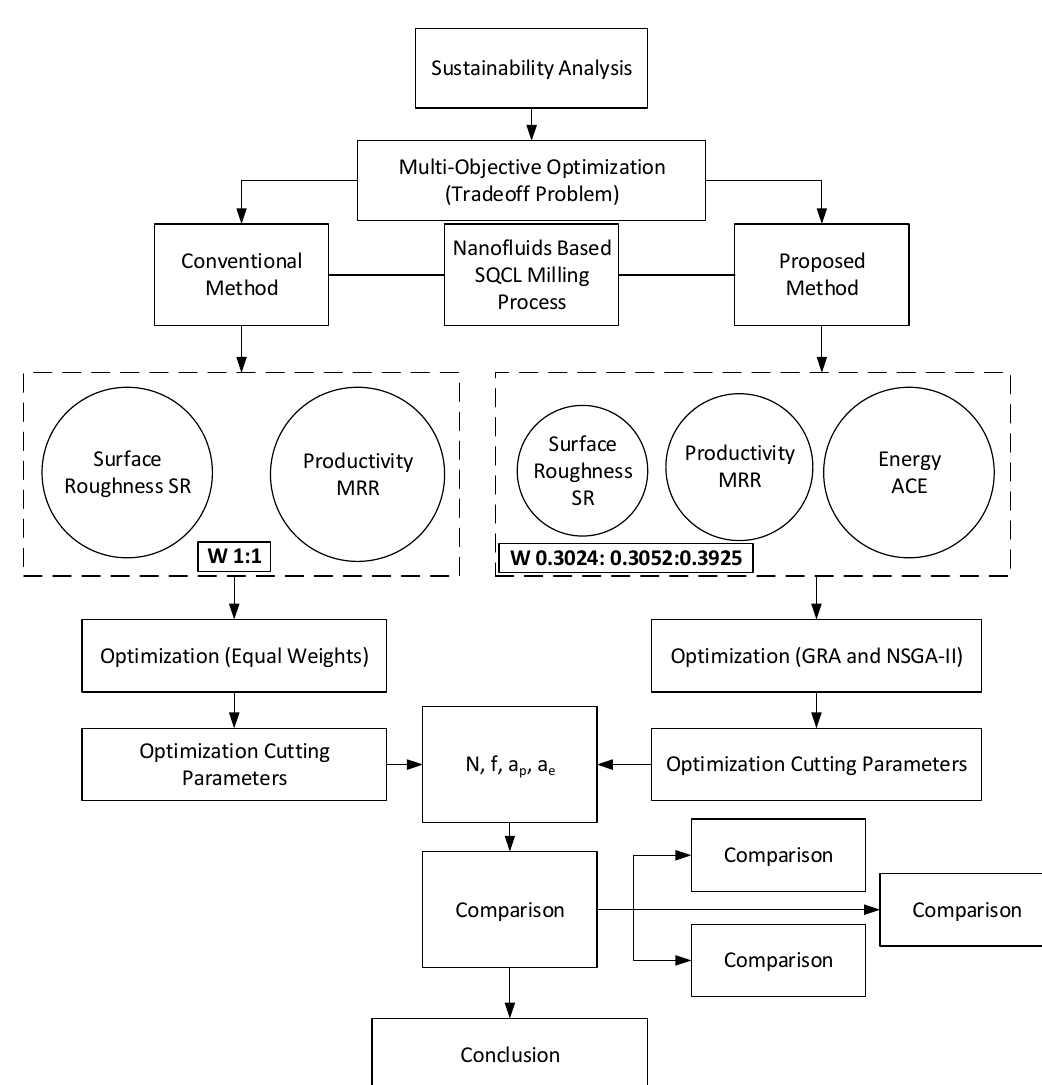
Figure 5. A framework for the energy reduction problem in the milling process. Experimental design L27 along with process parameters and obtained results are presented in